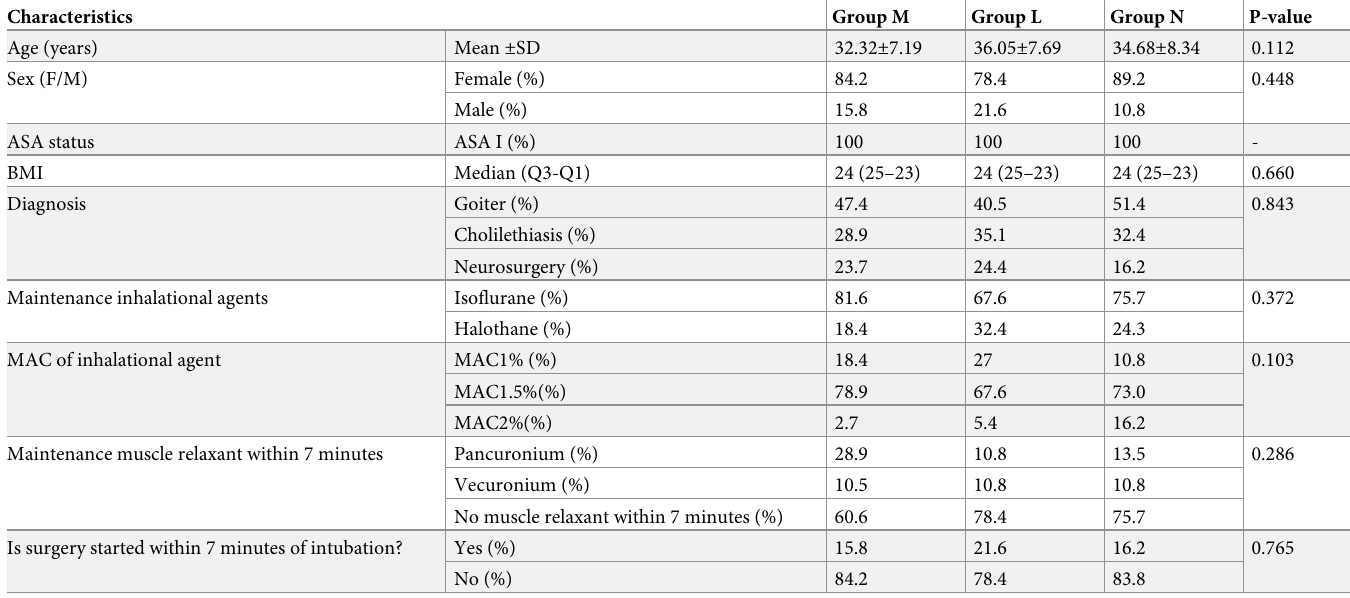
Data are analyzed by ANOVA, Kruskal Wallis, and Chi-Square Test, BMI-Body mass index, MAC- minimum alveolar